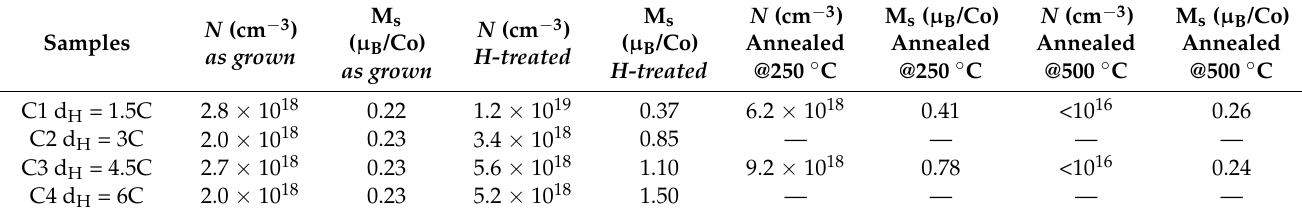
Table 2. Conductive and magnetic parameters for the samples C1, C2, C3, and C4 irradiated with four different H doses. C stands for 10 18 ions/cm 2 . Reproduced with permission from [25]. Copyright 2016 American Chemical